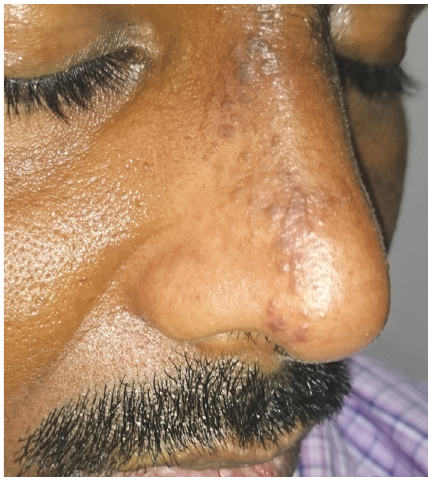
Figure 1: Multiple hyperpigmented papules and some vesicles present over the right side of the nose.